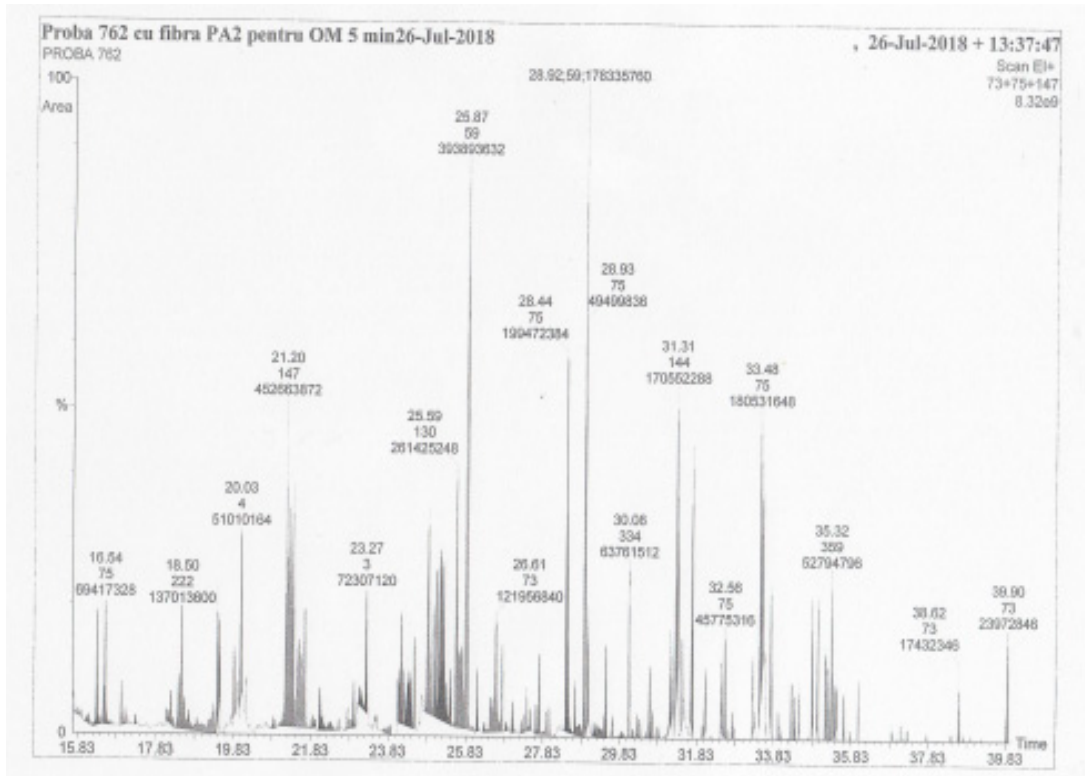
Figure 1. The mass chromatogram of organic compounds in the residual liquor sample.